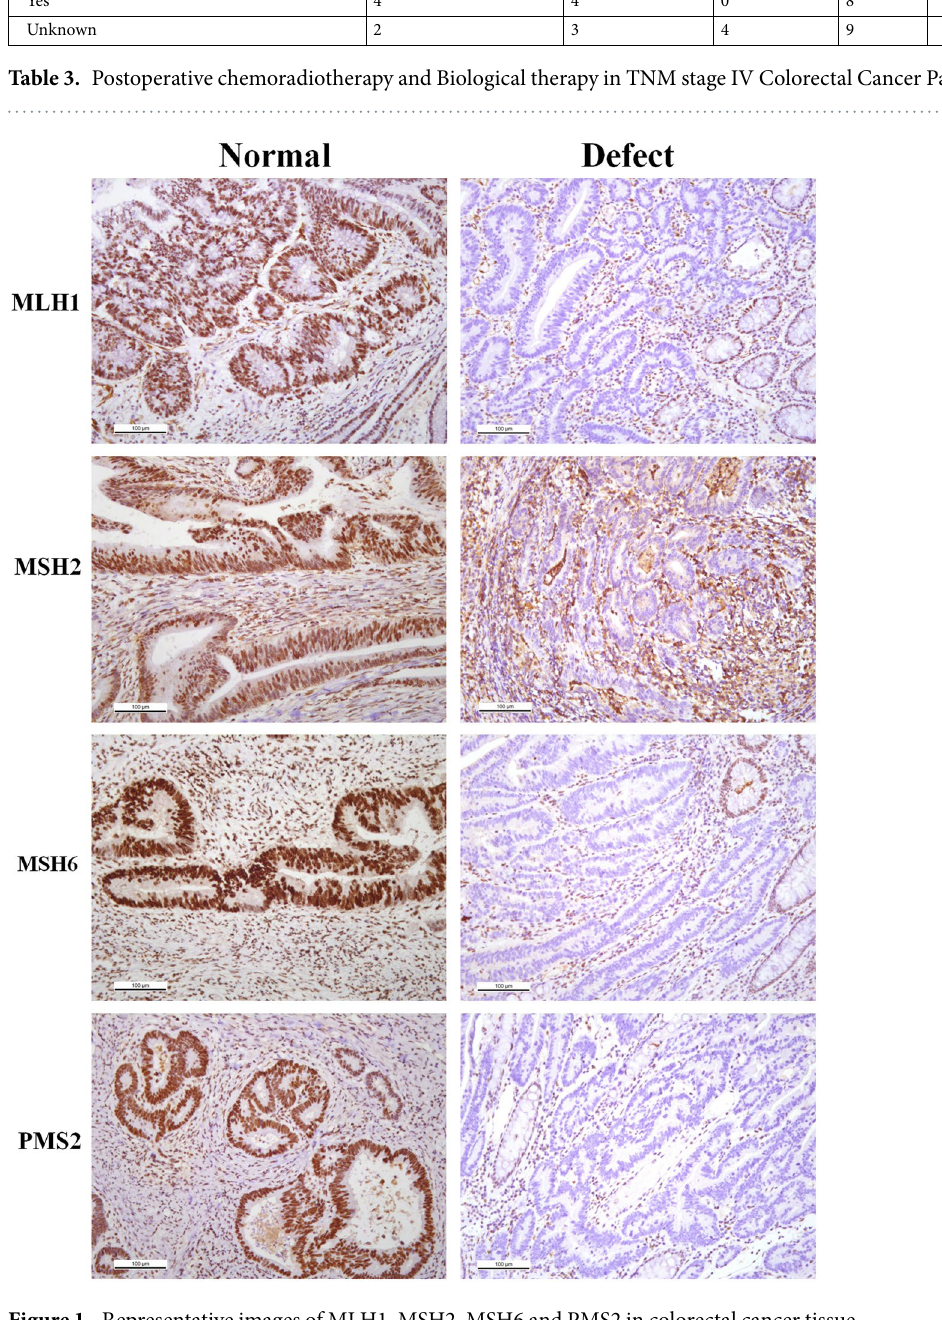
Figure 1. Representative images of MLH1, MSH2, MSH6 and PMS2 in colorectal cancer